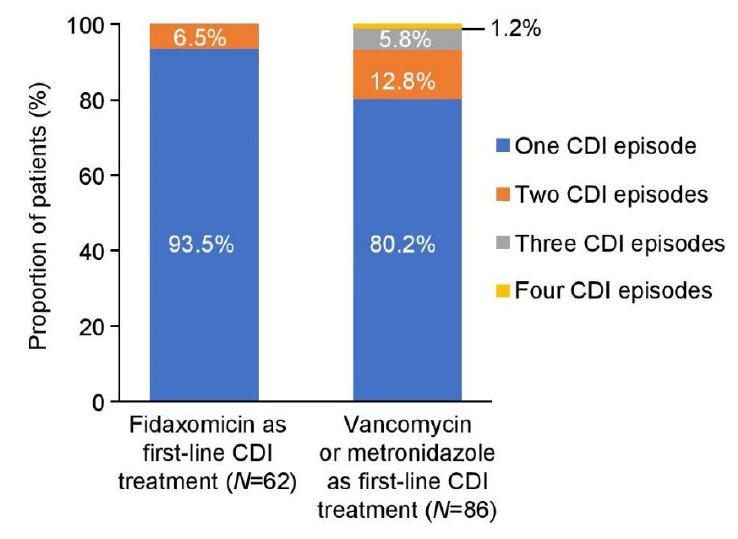
Figure 2. Recurrence of CDI episodes. CDI, Clostridioides difficile infection.